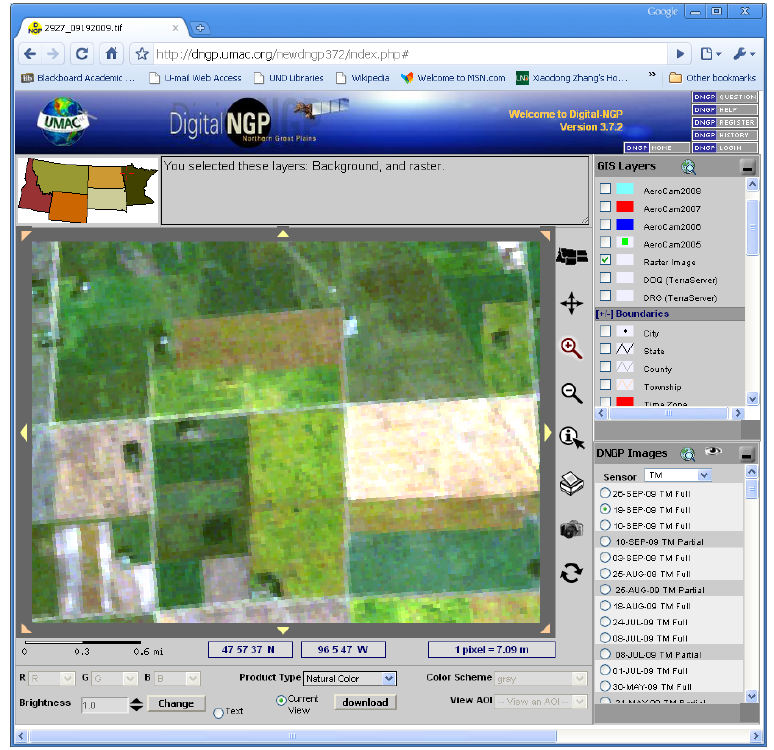
Figure 2. Screen-shot of the DNGP system displaying a Landsat TM image (color composite with bands 3, 2, and 1) acquired on September 19, 2009 farmland in Minnesota. Panels list available GIS layers (upper right) and all the images covering the area (lower